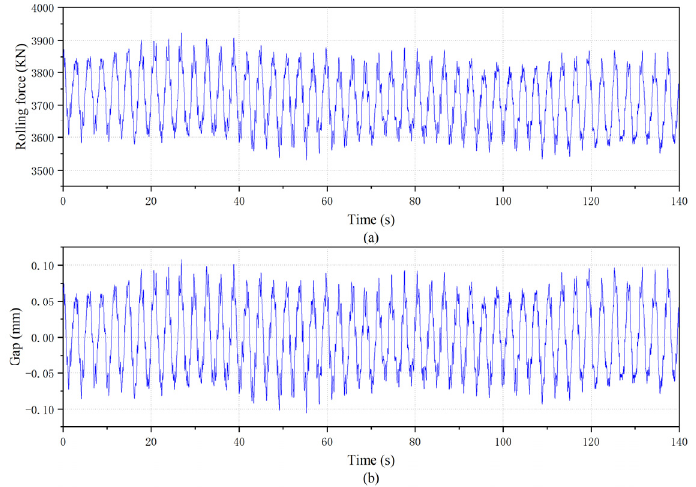
Figure 10. Curve of practical rolling data. ( a ) Rolling force; ( b ) roll gap. The L2 computer used the proposed SFFT-IAA to process the collected roll gap fluctuation data. First, SFFT was used to obtain the frequency distribution of the roll eccentricity signal (see Figure 11).